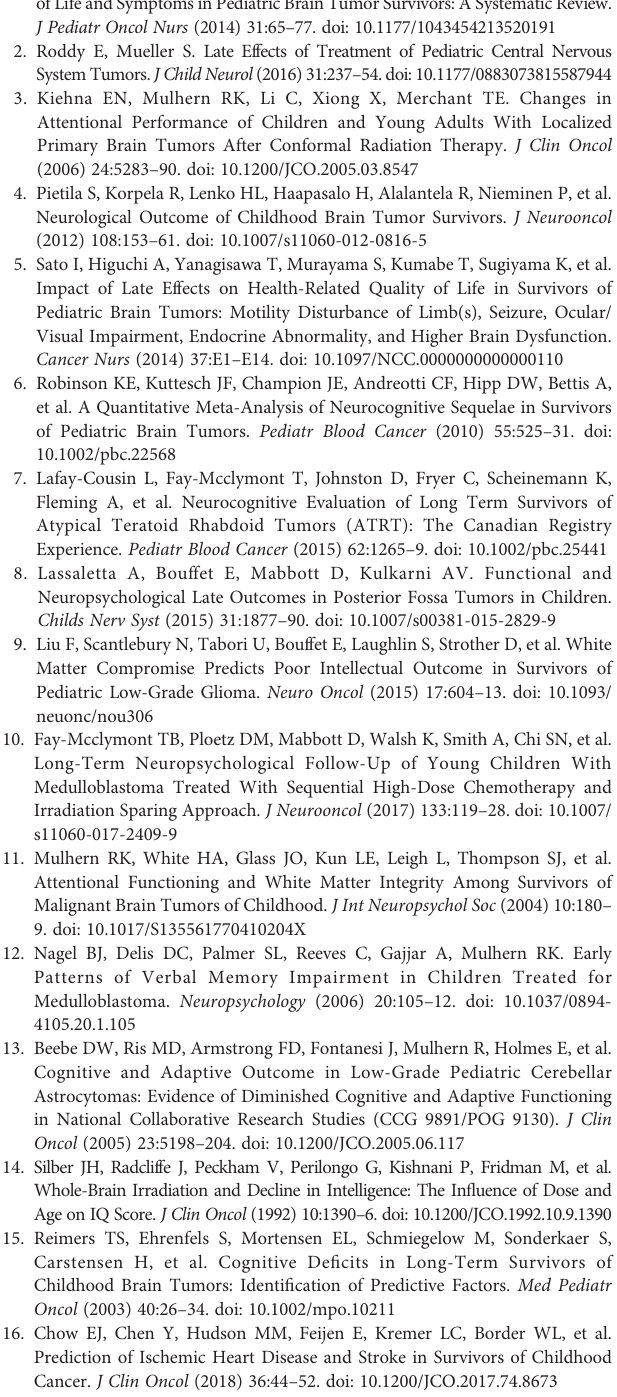
Supplementary Table 2 | Prevalence of candidate gene SNPs of interest across each investigated subcohort. Candidate gene allele frequencies by cohort across each